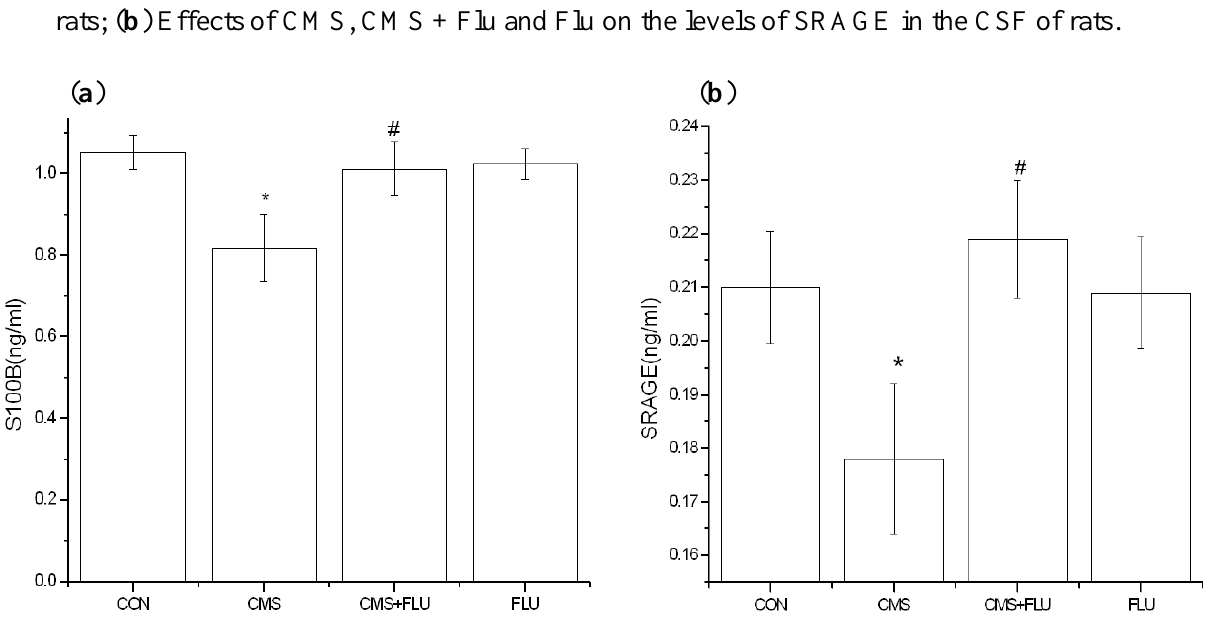
Figure 2. Effects of CMS, CMS + Flu and Flu on the levels of S100B and sRAGE in the CSF of rats. (* p < 0.05 vs. control, # p < 0.05 vs. CMS). Results are expressed